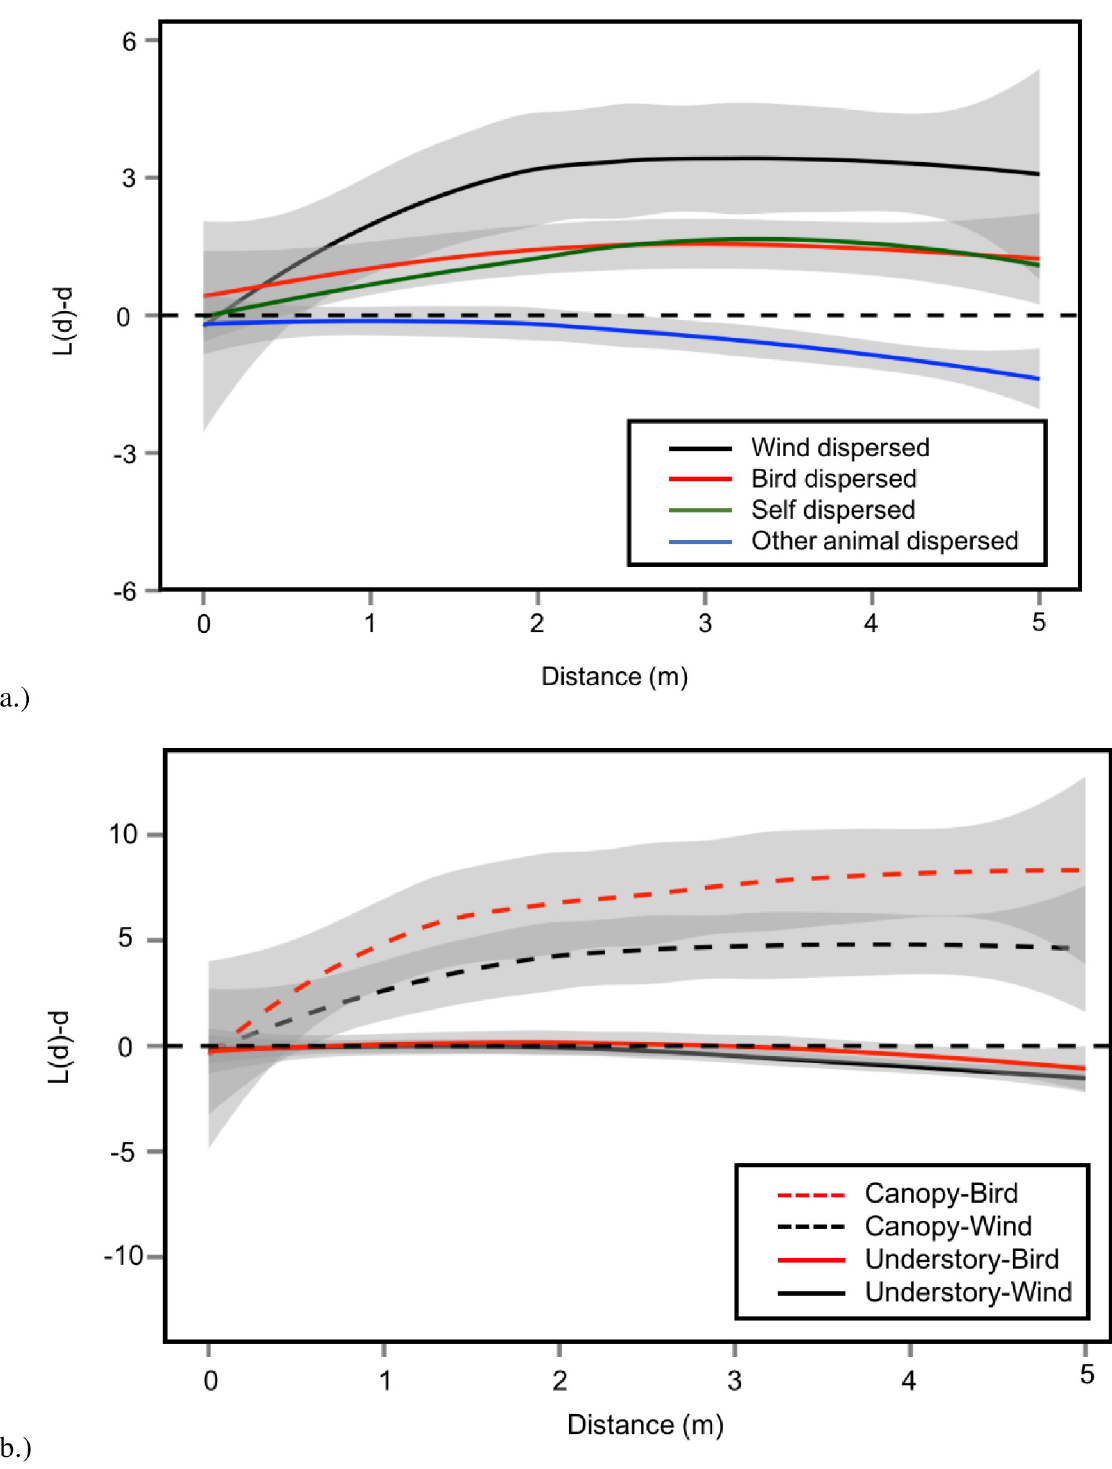
Fig 4. Pooled Besag’s L statistic across distance from spatial point pattern analysis of the woody plant community stratified by dispersal mechanism and plant type at Powdermill Nature Reserve in southwestern Pennsylvania. a.) Wind dispersed(n = 16), bird dispersed (n = 23), and self dispersed(n = 2) species were significantly more overdispersed than species dispersed by animals other than birds (n animal = 6). b.) Canopy plants were significantly more overdispersed than understory plants regardless of dispersal mechanism(n canopy-bird = 5, n canopy-wind = 12, n understory-bird = 18, n understory-wind = 5). Bird dispersal was emphasized here; however, plants did not differ significantly